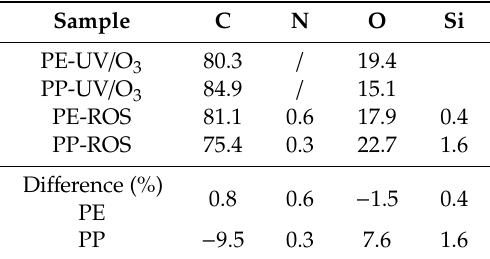
Table 6. Surface chemical composition of the reference foils and foils treated by rosemary coating (at. %).